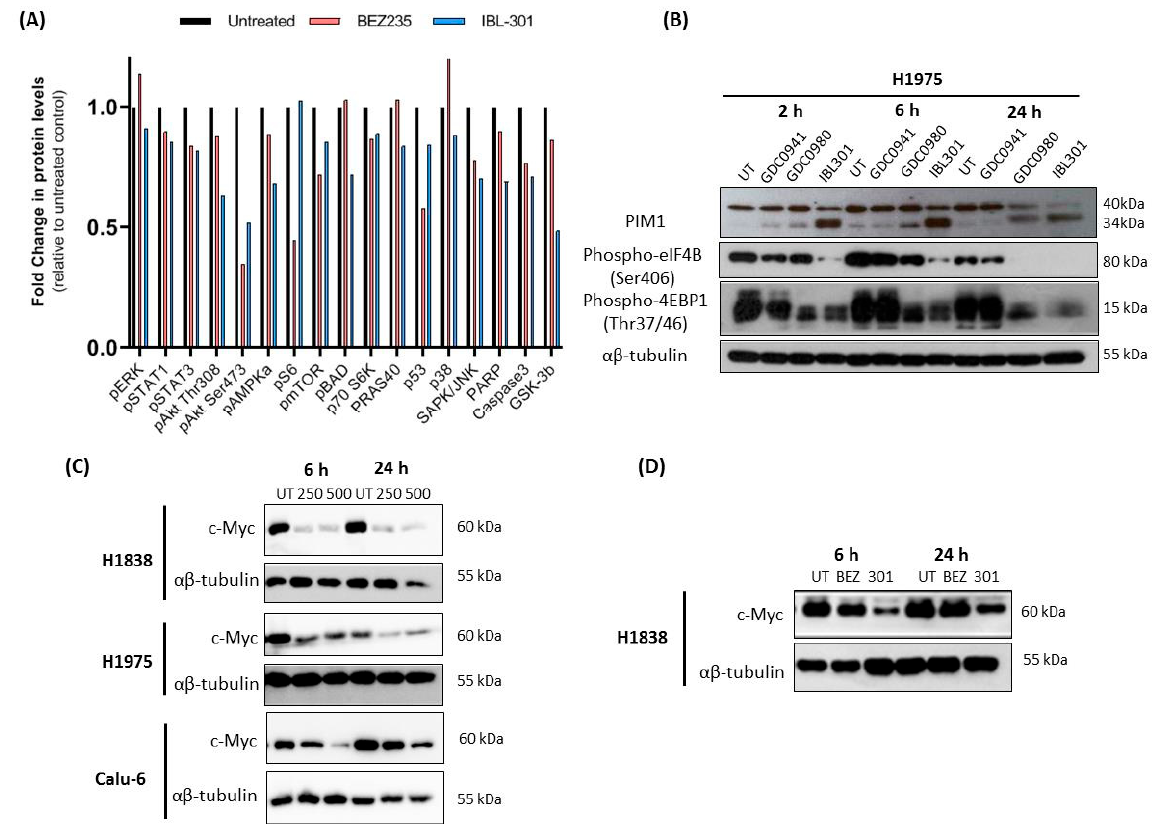
Figure 4. IBL-301 alters NSCLC cell line protein expression and signaling pathways. ( A ) H1975 cells were treated with DMSO vehicle control, 250 nM PI3K/mTOR inhibitor BEZ235 or 250 nM PI3K/mTOR/PIM inhibitor IBL-301 for 24 h, pro-